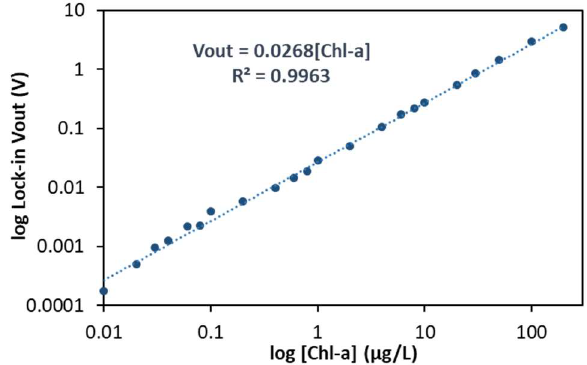
Figure 13. Calibration curve of the sensor using chlorophyll a standard solutions.